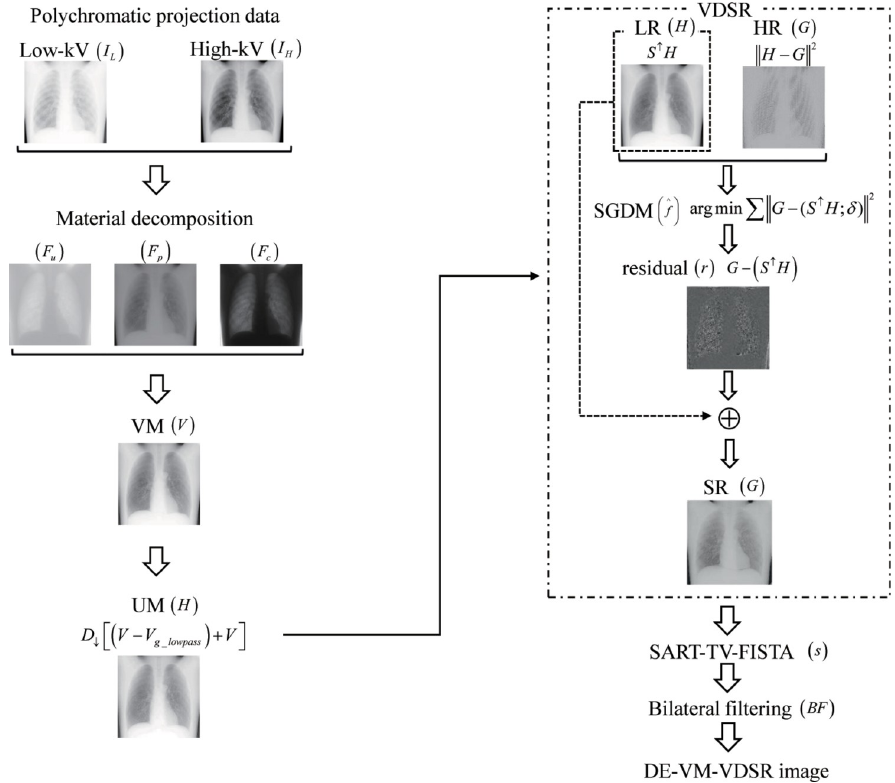
Fig 1. Flowchart of the Dual-Energy (DE) Virtual Monochromatic (VM) with Very-Deep Super-Resolution (VDSR) reconstruction algorithm (DE–VM–VDSR) and Bilateral Filtering (BF). DE–VM–VDSR with BF is implemented by combining preprocessing [VM and VDSR with unsharp masking (UM)] and postprocessing (BF).